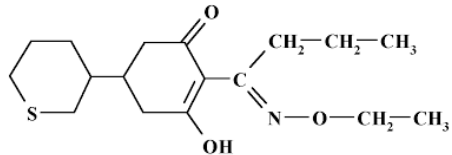
Figure 2. Structure of cycloxydim. Molecular mass: 325.5 g/mol.